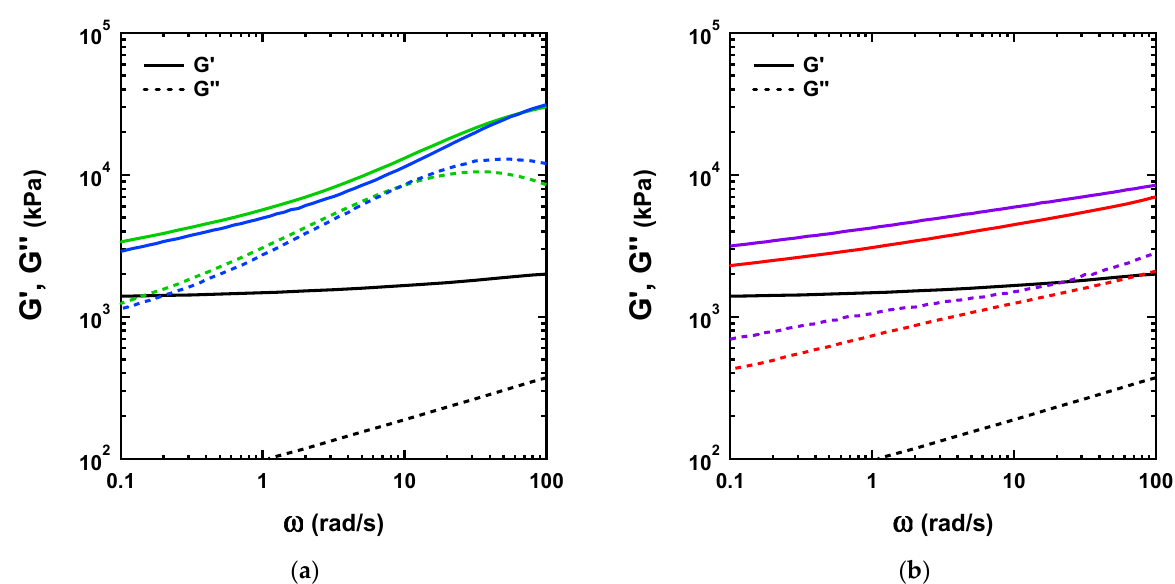
Figure 8. ( a ) Storage and loss moduli as a function of angular frequency for the chemical gel (black), and P(AAm- co -VIm)- Ni 2+ dual-crosslink gels prepared by the one-pot synthesis (blue) and by the diffusion method (green). ( b ) Storage and loss moduli as a function of the angular frequency for the chemical gel (black), and P(AAm- co -VIm)-Zn 2+ dual-crosslink gels prepared by the one-pot synthesis (purple) and by the diffusion method (red).